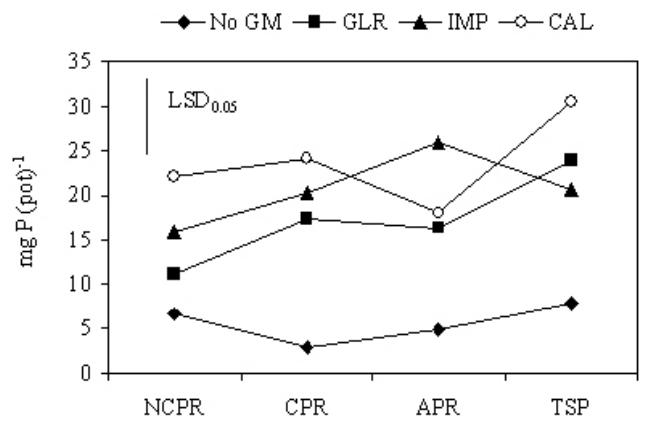
FIGURE 12. Total fertilizer-P uptake (indirectly quantified with 32 P) by Setaria sphacelata grown for 20 weeks in a tropical soil treated with inorganic P fertilizers and